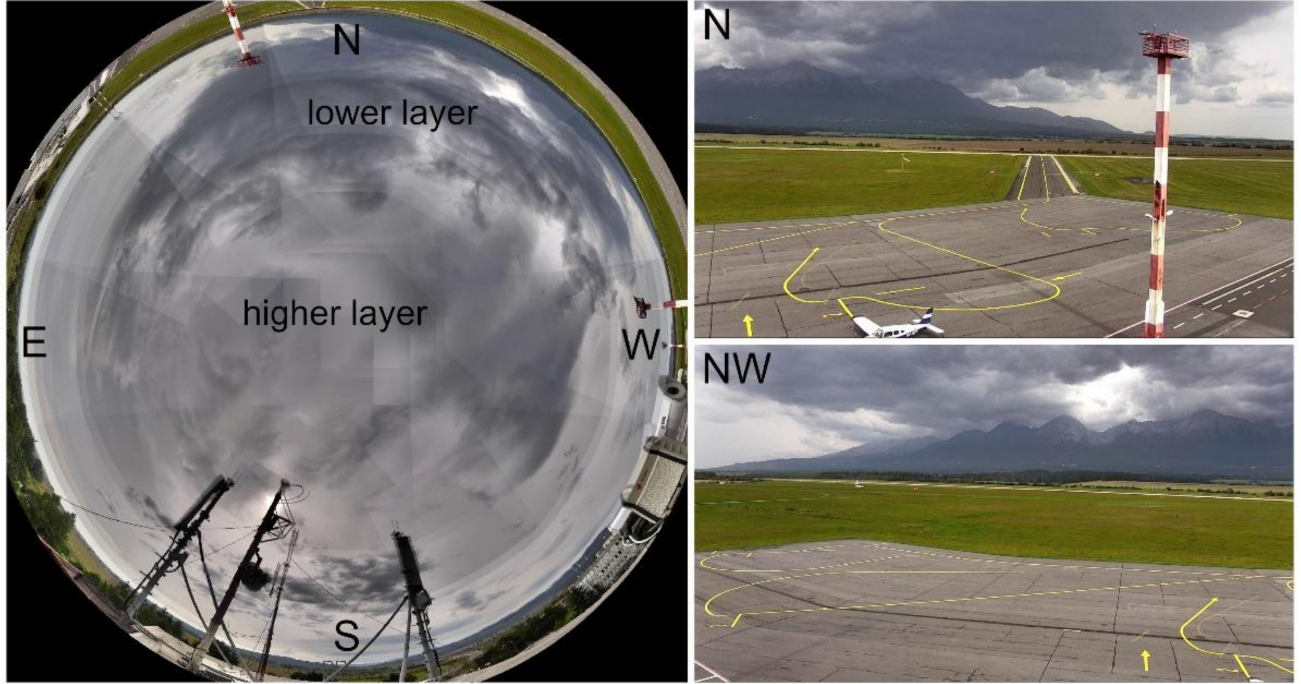
Figure 9. Determination of the maximum cloud cover and the minimum cloud base height using cameras at LZTT, on 11 September 2018, at 09:20 UTC.